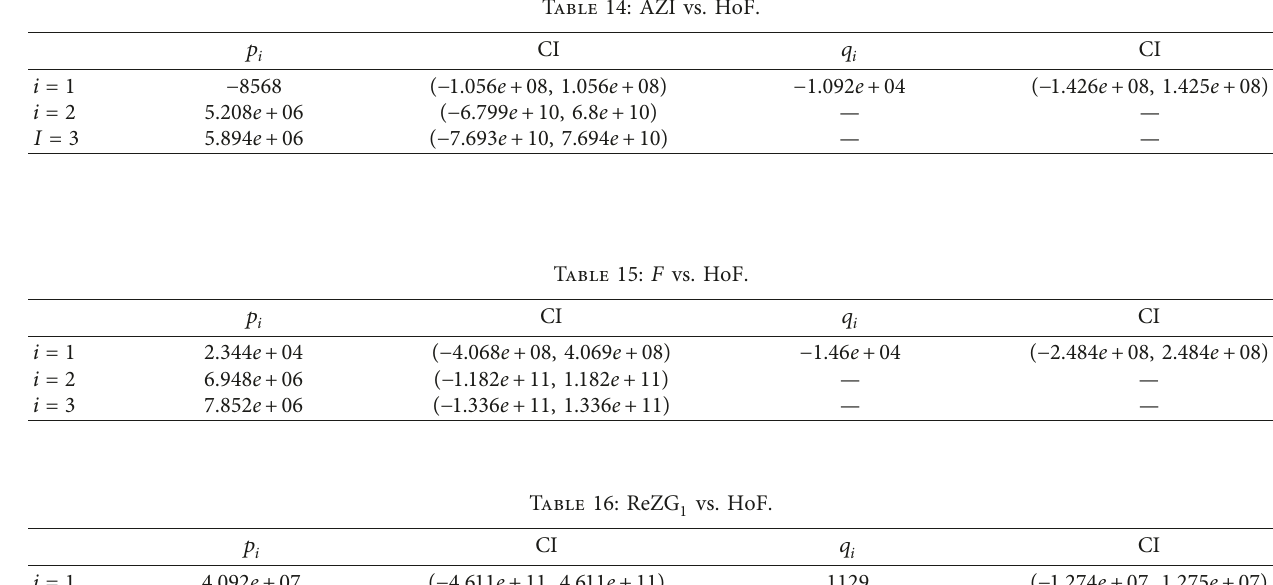
Table 14: AZI vs. HoF.